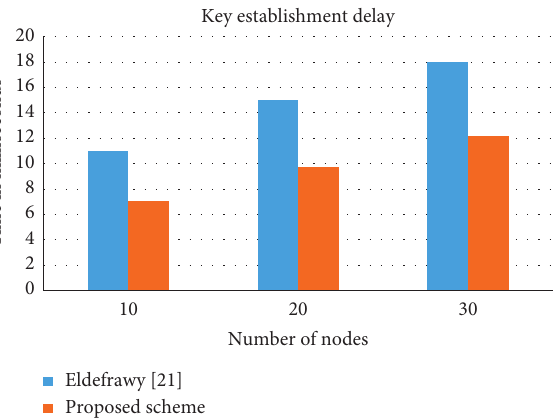
Figure 5: Key establishment